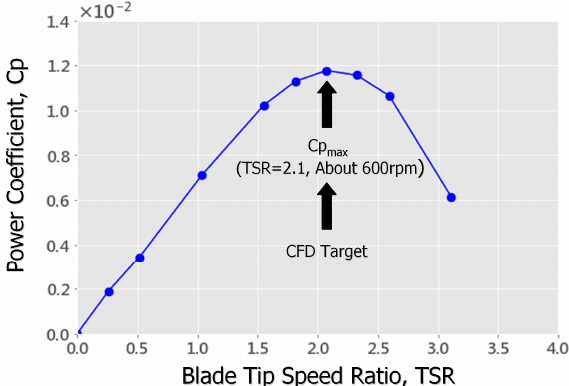
Figure 5. Relationship between the tip speed ratio (TSR; horizontal axis) and the power coefficient Cp. (vertical axis) of the 1/88 scale wind turbine model obtained in the wind tunnel experiment.